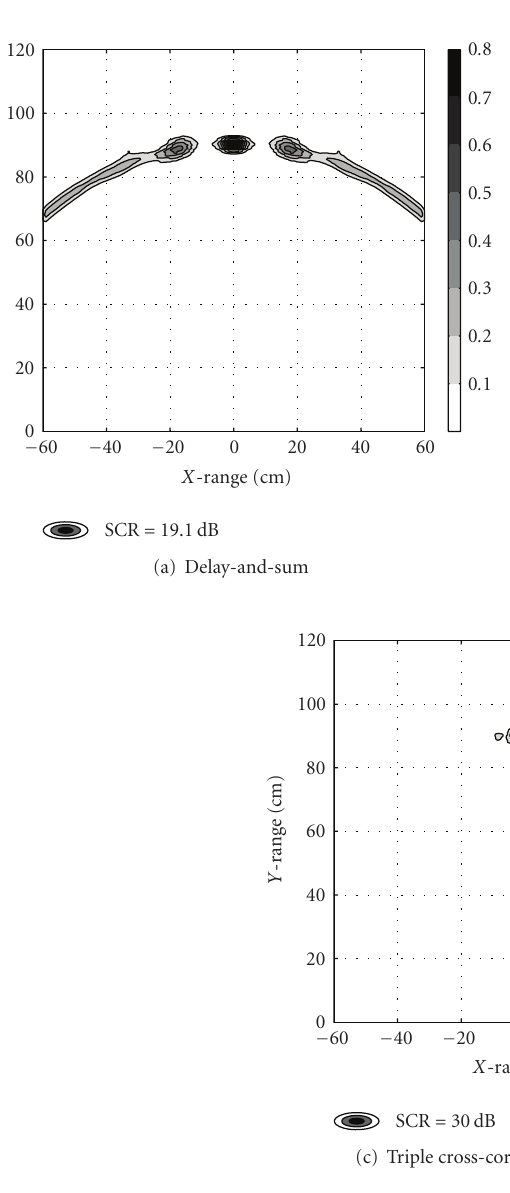
Figure 2: Grey-scale images of spatial power deposition in numerical test scenario.